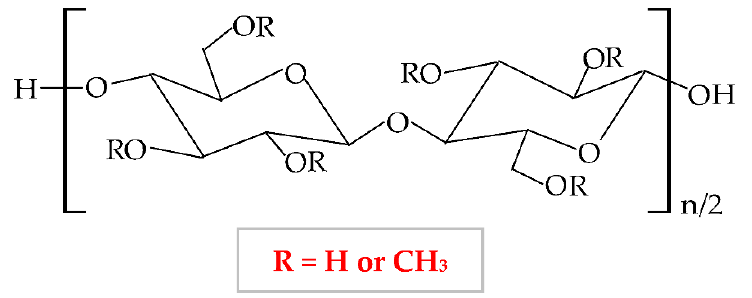
Figure 9. Chemical structure of methylcellulose (MC).